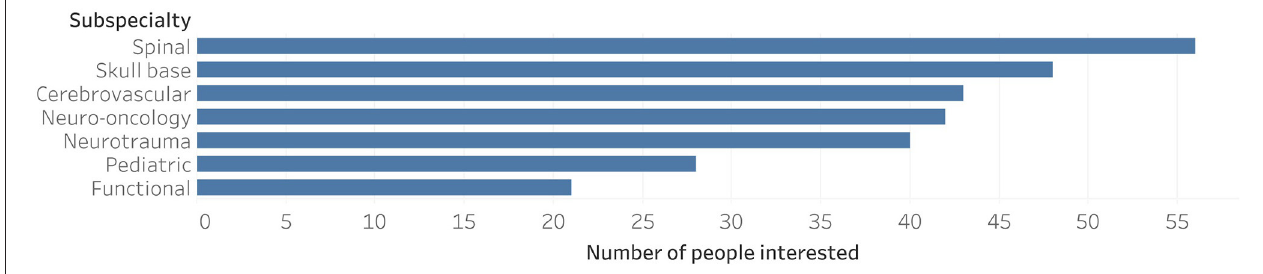
FIGURE 2 | Subspecialty interests.